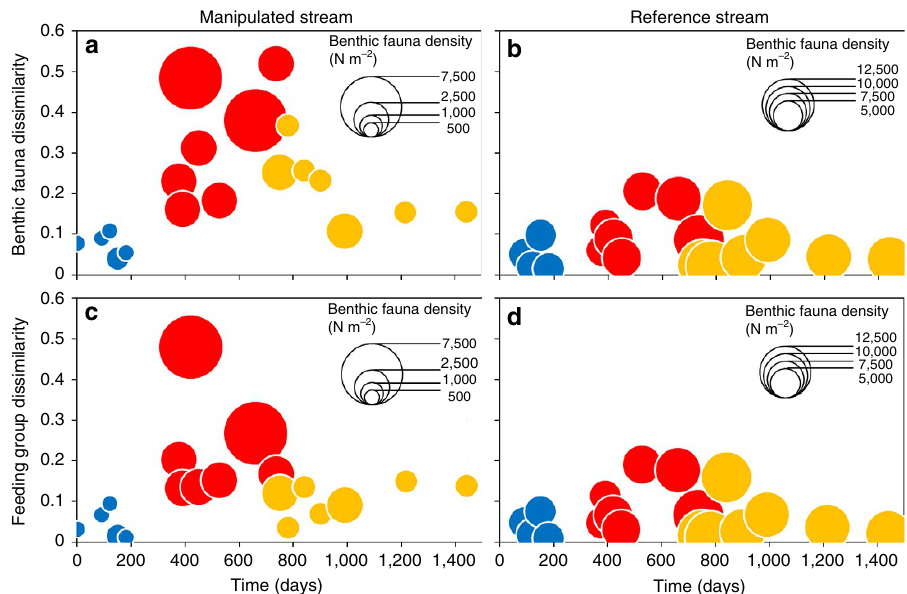
Figure 2 | Temporal variability in benthic fauna and feeding group dissimilarity between reaches of the manipulated and reference stream. Benthic fauna and feeding group dissimilarity between downstream and upstream reaches in the manipulated stream ( a , c ) and between subsequent sampling dates in the reference stream ( b , d ). The three experimental phases are shown in different colours (blue: base flow; red: flow alteration; yellow: flow recovery). Dot size refers to benthic fauna density. Note difference in dot size in the reference and manipulated streams due to much higher overall density in the reference